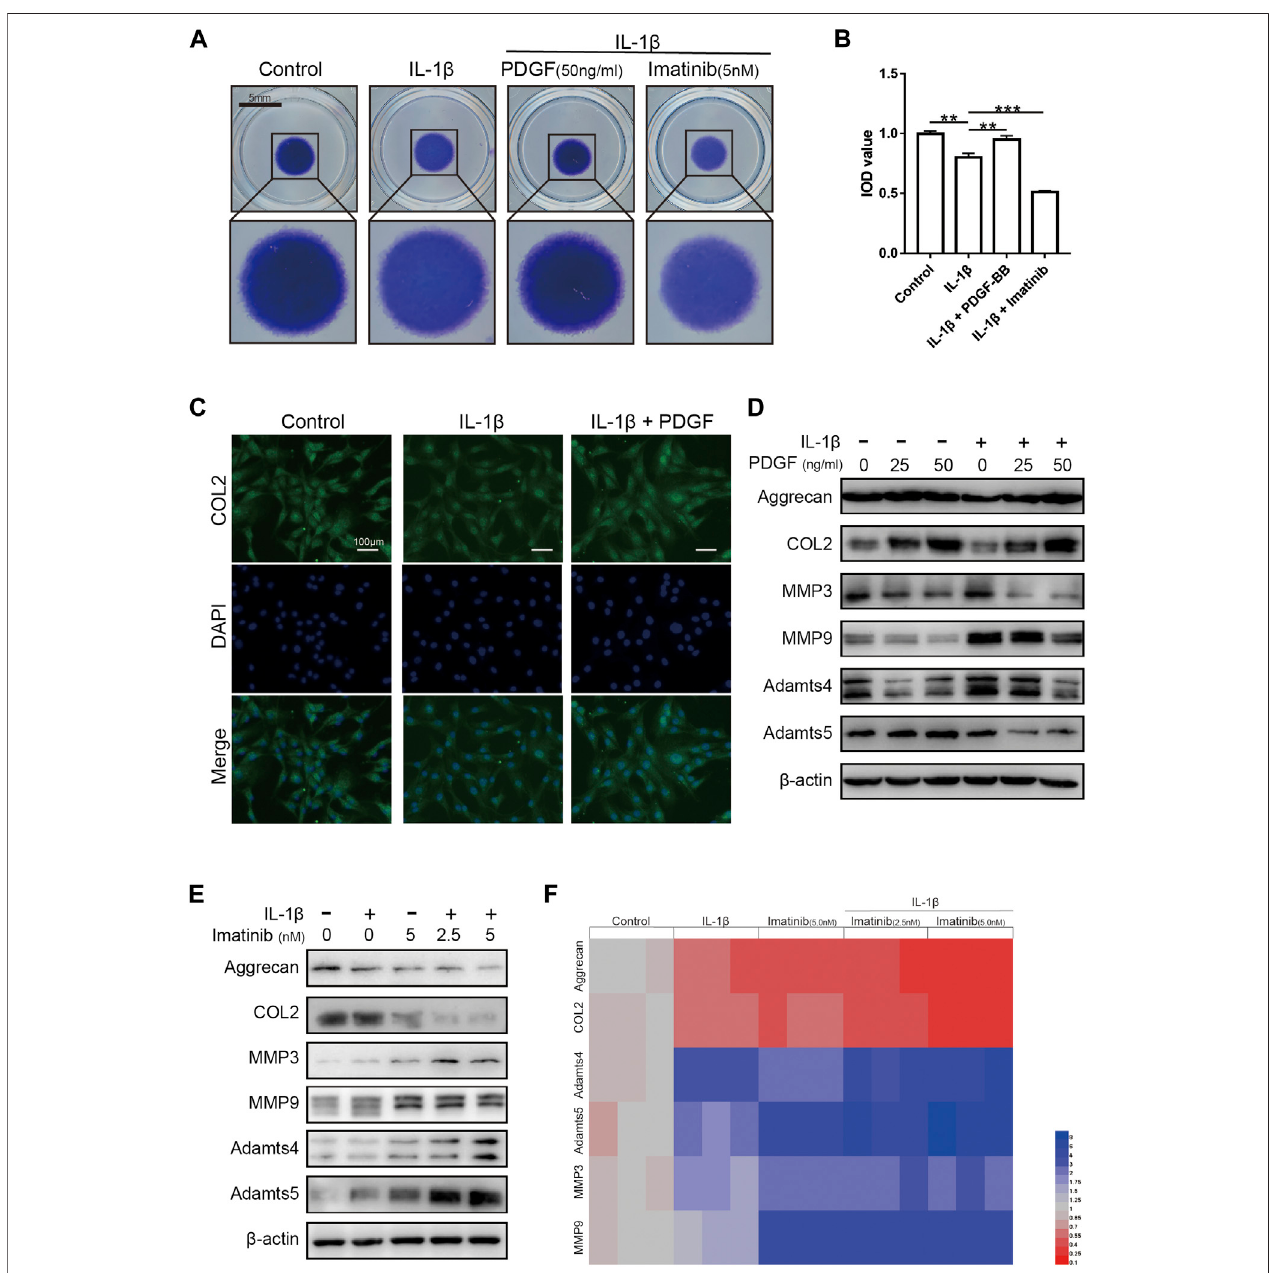
FIGURE 4 | The effect of PDGF-BB on the anabolism and catabolism of ECM in NPCs treated with IL-1 β . (A,B) Toluidine blue staining of NP cells on high-density culture after treatment with IL-1 β , PDGF-BB and Imatinib for 7 days. Scale bar, 5 mm. (C) Representative images of NP cells treated with IL-1 β and PDGF-BB for 48 h. Scale bar, 100 μ m. (D) The expression of anabolic-related proteins and catabolism-related proteins were measured by western blot. All NP cells were treated with or without IL-1 β (10 ng/ml) and PDGF-BB for 48 h. (E) The expression of anabolic-related proteins and catabolism-related proteins were measured by western blot. All NP cells were treated with or without IL-1 β (10 ng/ml) and Imatinib for 48 h. (F) The mRNA expression levels of Aggrecan, COL2, MMP3, MMP9, Adamts4 and Adamts5weremeasuredbyqPCR.TheexpressionofthesegeneswasnormalizedtotheexpressionofGAPDH.Dataarepresentedasthemean ± SD. n (cid:1) 3.Signi fi cant differences between groups are indicated as *** p < 0.001, ** p <